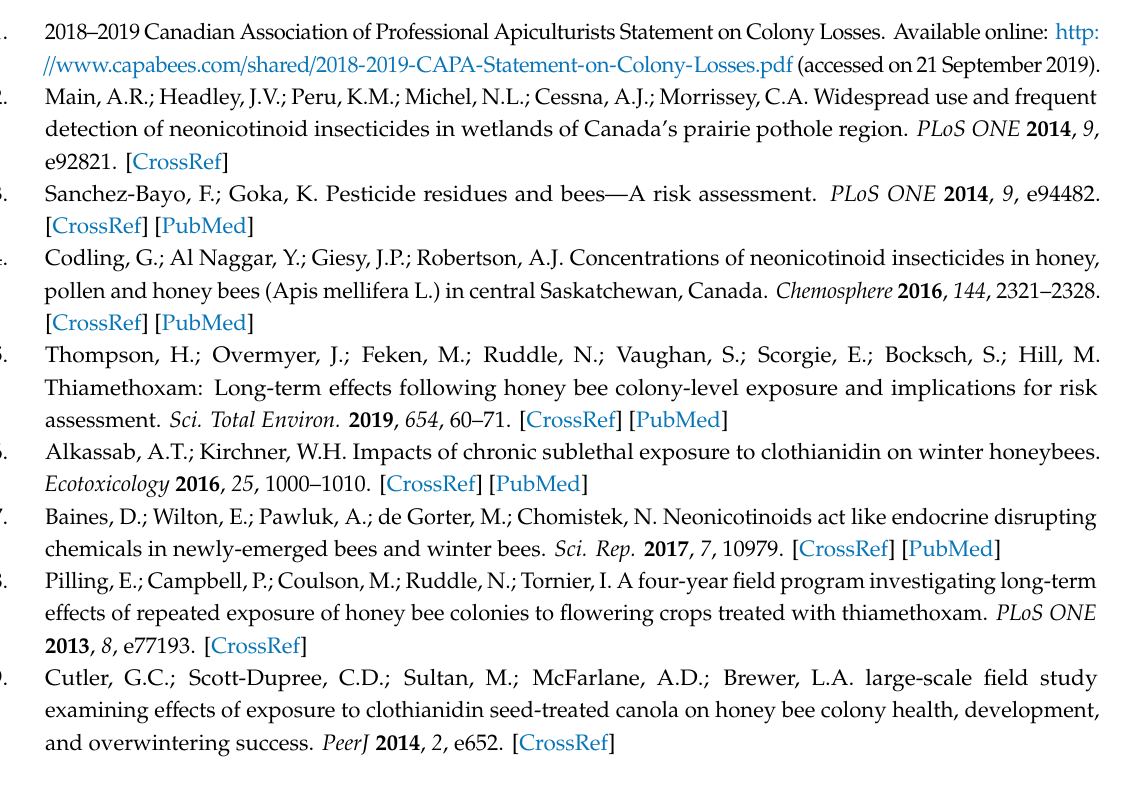
Table S1: Survival analysis of winter Apis mellifera workers chronically exposed to thiamethoxam (THI) or clothianidin (CLO) through syrup during laboratory cage trial C1. Table S2: Survival analysis of winter Apis mellifera workers chronically exposed to thiamethoxam (THI) or clothianidin (CLO) through syrup during laboratory cage trial